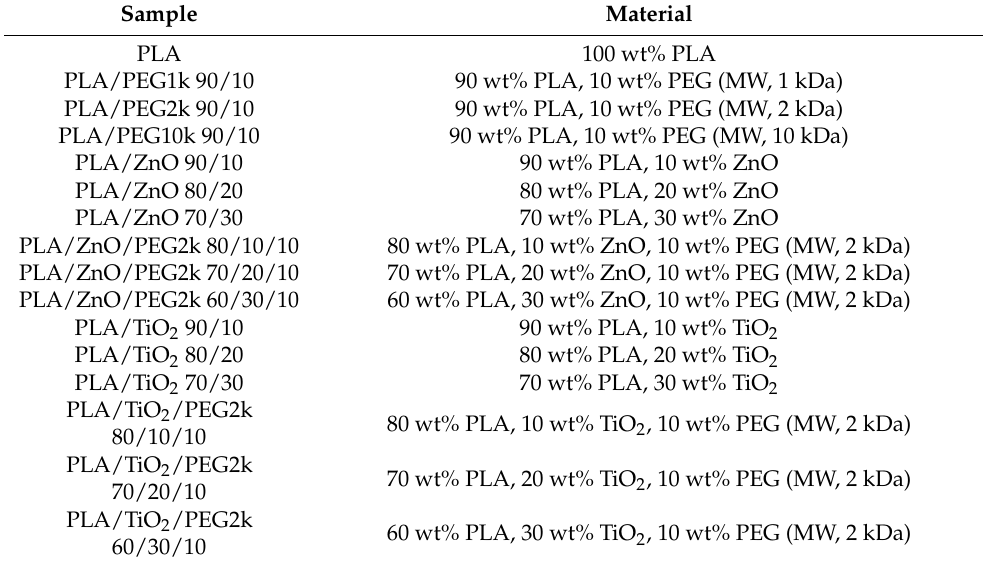
Table 1. List of the composite filaments made in this study and their designations. Sample